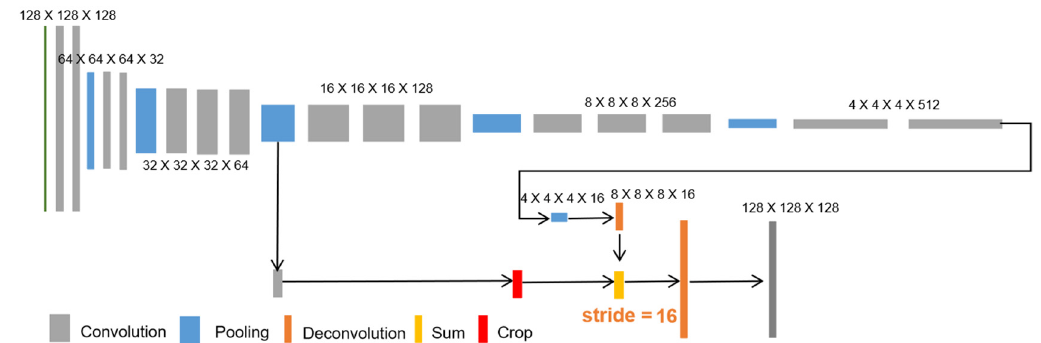
Figure 9. When the stride is 16, we use the skip architecture and crop operation to enhance the accuracy of the prediction results. The steps are as follows: 1) the 4 × 4 × 4 × 16 feature map is up-sampled to 8 × 8 × 8 × 16 image, 2) the results of the third pooling are cropped to 8 × 8 × 8 × 16 image, 3) sum up the two 8 × 8 × 8 × 16 images, and 4) the predicted result of 128 × 128 × 128 is obtained through deconvolution.